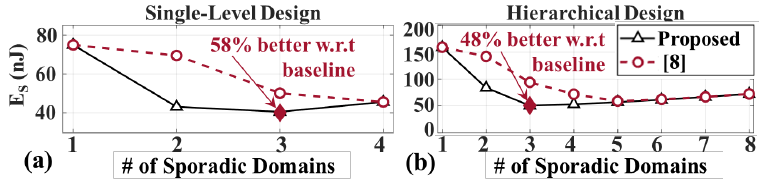
Figure 7. E S vs. # of sporadic domains for designs in ( a ) Section 5.2.1 ( b ) Section